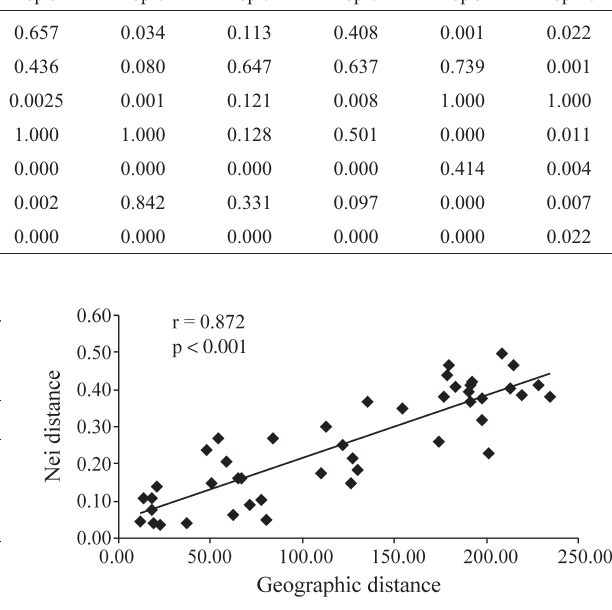
Table 5 - Probabilities of goodness-of-fit test (Fisher’s exact test) to Hardy-Weinberg equilibrium for each locus. Locus